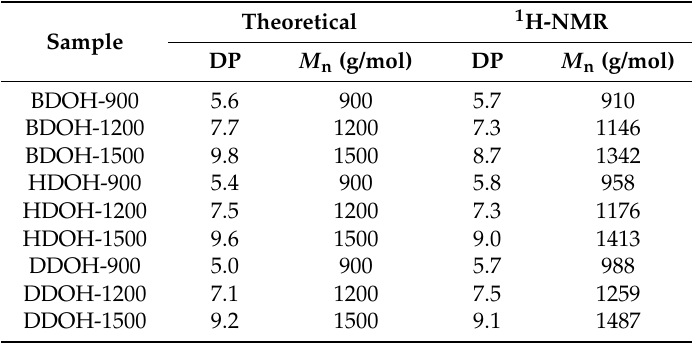
Table 2. Molecular weights of synthesized oligolactide diols.